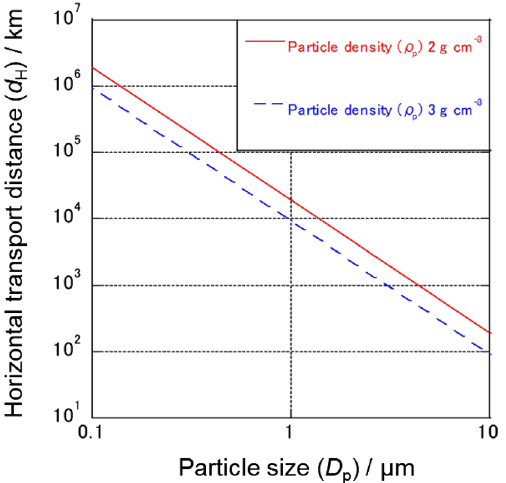
Figure 6. Relationship between horizontal transport distance and particle size by